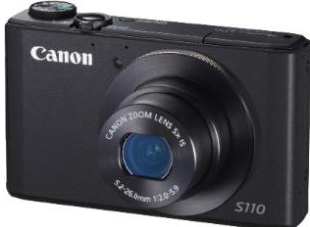
Figure 2 Non-metric camera (Canon power shot S110)